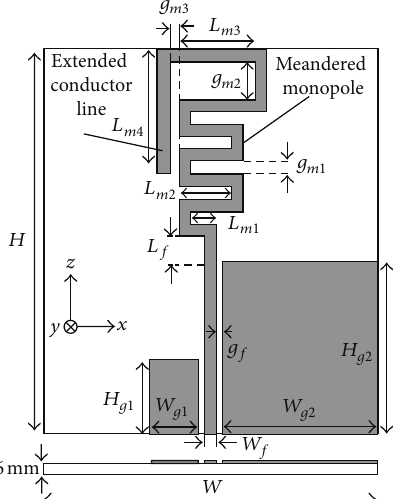
Figure 1: Geometry of the proposed antenna with asymmetrical ground plane.